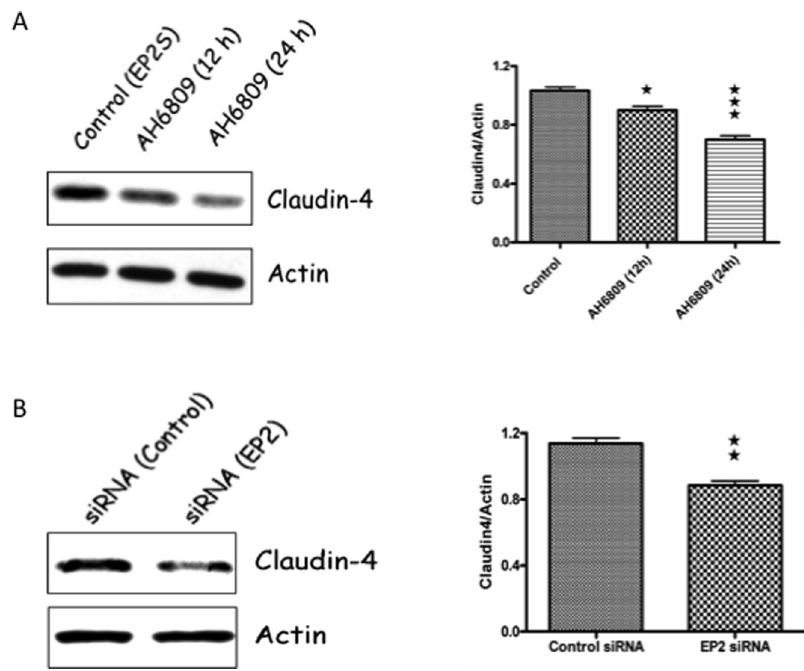
Figure 5. Pharmacological inhibition and/or siRNA silencing of EP2 receptor in EP2S cells decrease claudin-4 expression. (A) EP2S cells that reached confluence on regular culture plates were exposed with 50 m M of AH6809 (EP2 antagonist) for the time indicated and the cell lysate analyzed for claudin-4 expression by western blotting. Actin used as the internal control for the densitometry analysis. (B) EP2S cells seeded on culture plates that reached 60 percent confluence were transfected with either EP2 receptor or control siRNA. Cells collected after 48 h were checked for claudin-4 expression by western blotting and quantified by densitometry analysis for claudin-4 expression. w p , 0.05; ww p , 0.01 and www p , 0.001.